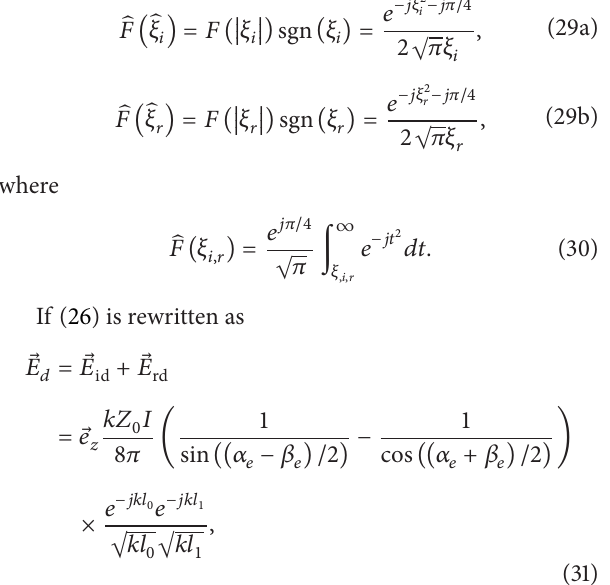
Figure 5. The solution is continuous for the uniform